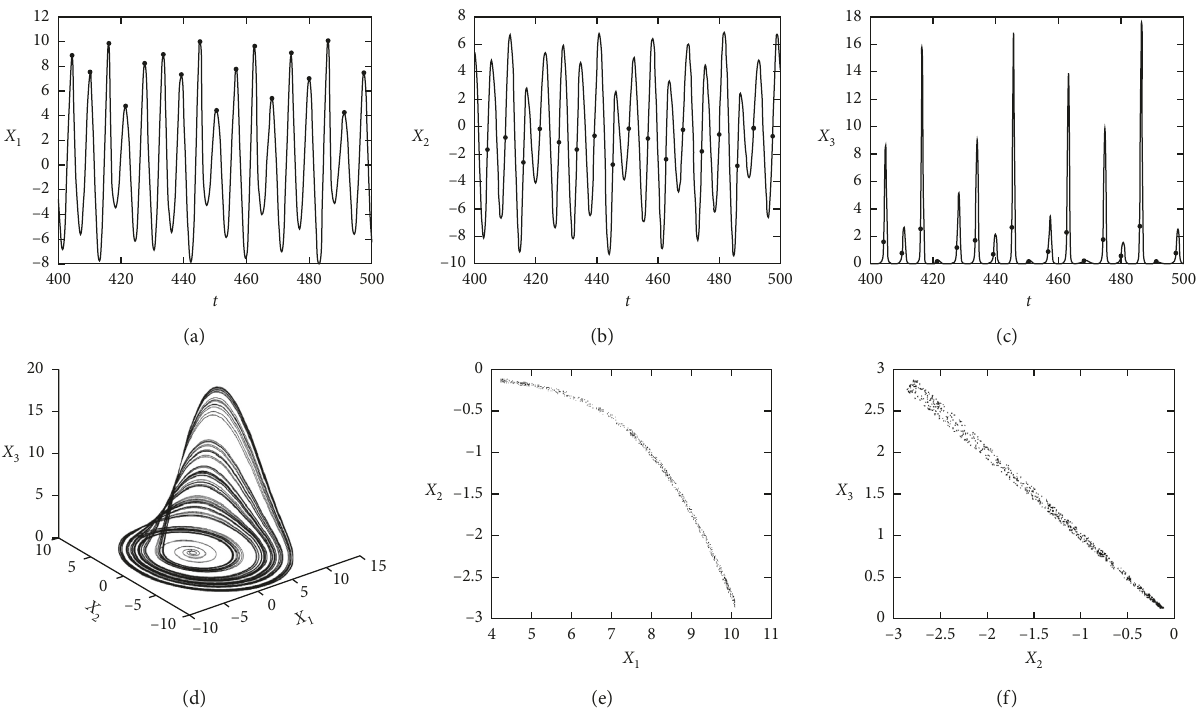
Figure 6: Vibration characteristics of R¨ossler dynamic system for a